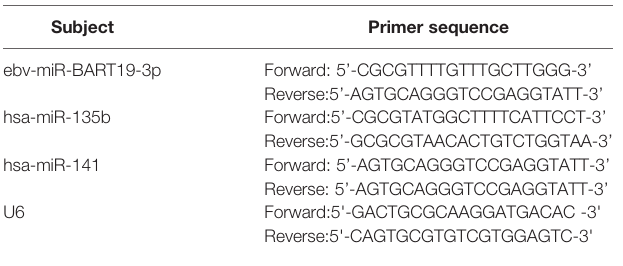
TABLE 1 | The sequence of the